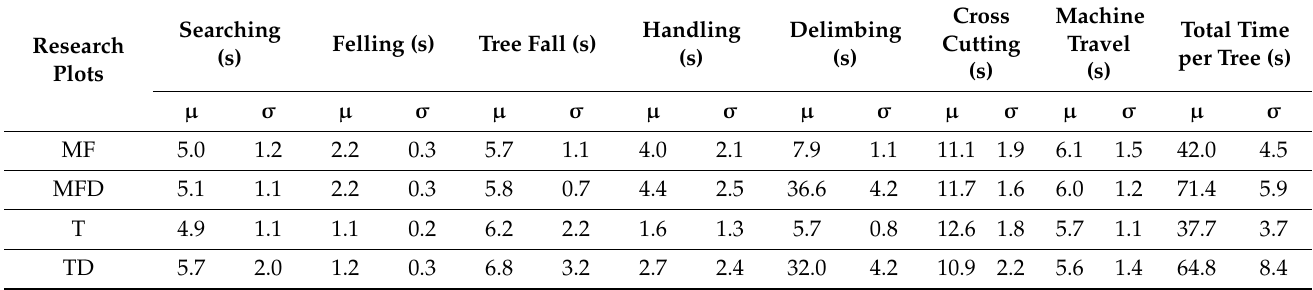
Table 2. Results of the time